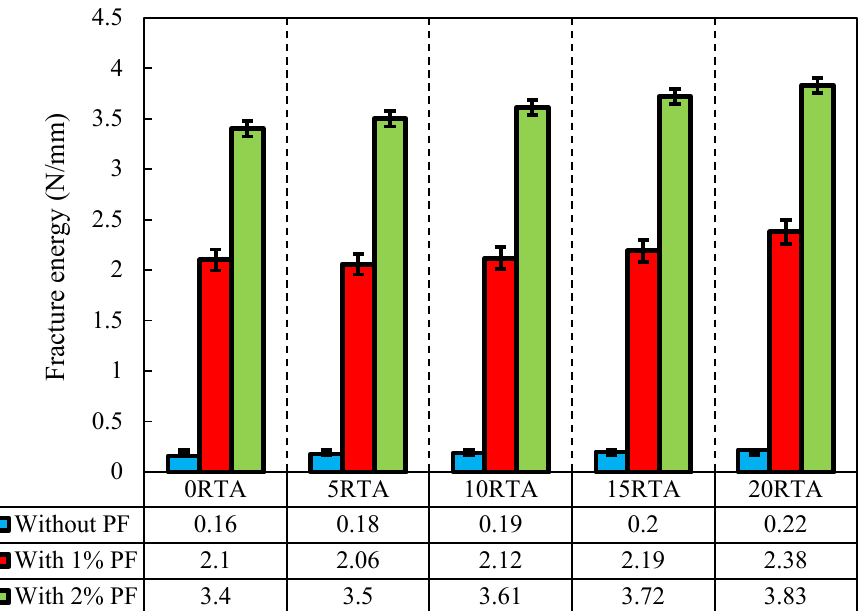
Figure 12. Effect of the PF and RTA on the fracture energy.